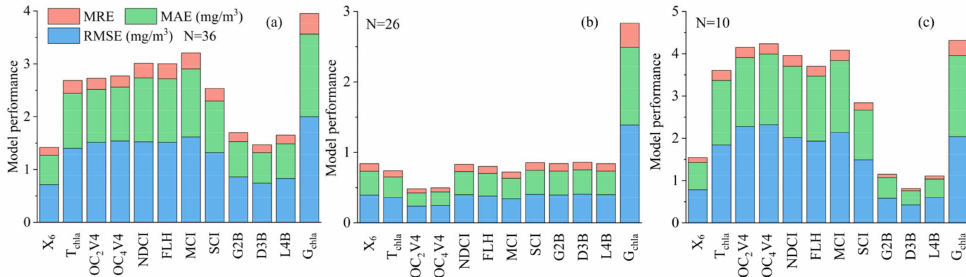
Figure 6. The performance metrics of the twelve chl-a concentration retrieval models. (N is the number of samples). ( a ) All water samples, ( b ) samples with low chl-a concentration, and ( c ) samples with high chl-a concentration.